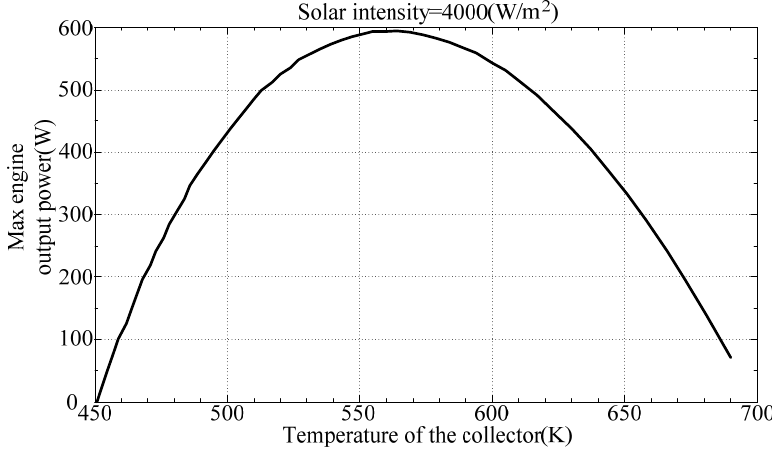
Figure 7. Maximum engine output power with respect to collector temperature.